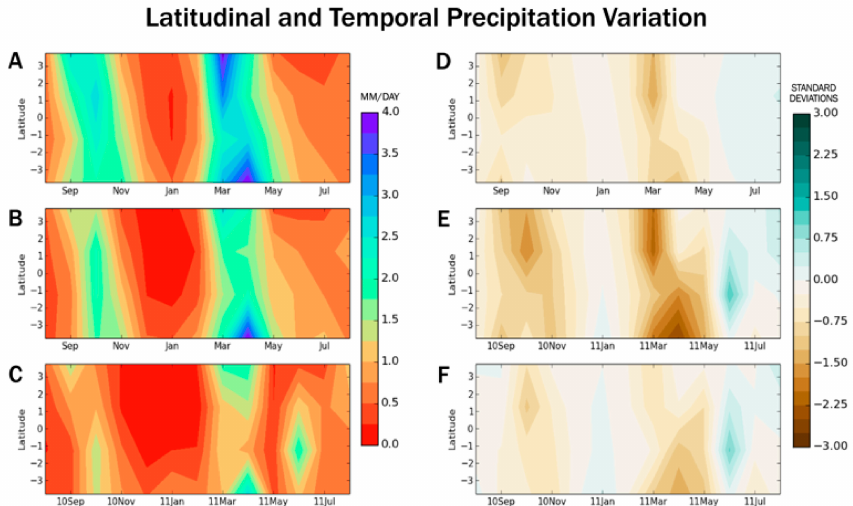
Figure 5. The 2010–2011 drought was spatially and temporally unique. The left column represents monthly rainfall climatology (GPCP) ( A ), drought climatology (alternatively referred to as a drought composite—an average of previous regional droughts ( B ), and 2010–2011 rainfall ( C ). Cool colors represent high rainfall. The right column represents average rainfall anomaly (B minus A) during drought years ( D ), 2010–2011 rainfall anomaly (C minus A) ( E ), and drought anomaly (E minus D or precipitation anomaly as compared to the drought composite average anomaly) ( F ). Brown values represent anomalously low rainfall whereas blue values represent greater than expected (anomalously high) rainfall. The anomaly was averaged along the longitude between 38.5°E and 46.5°E.